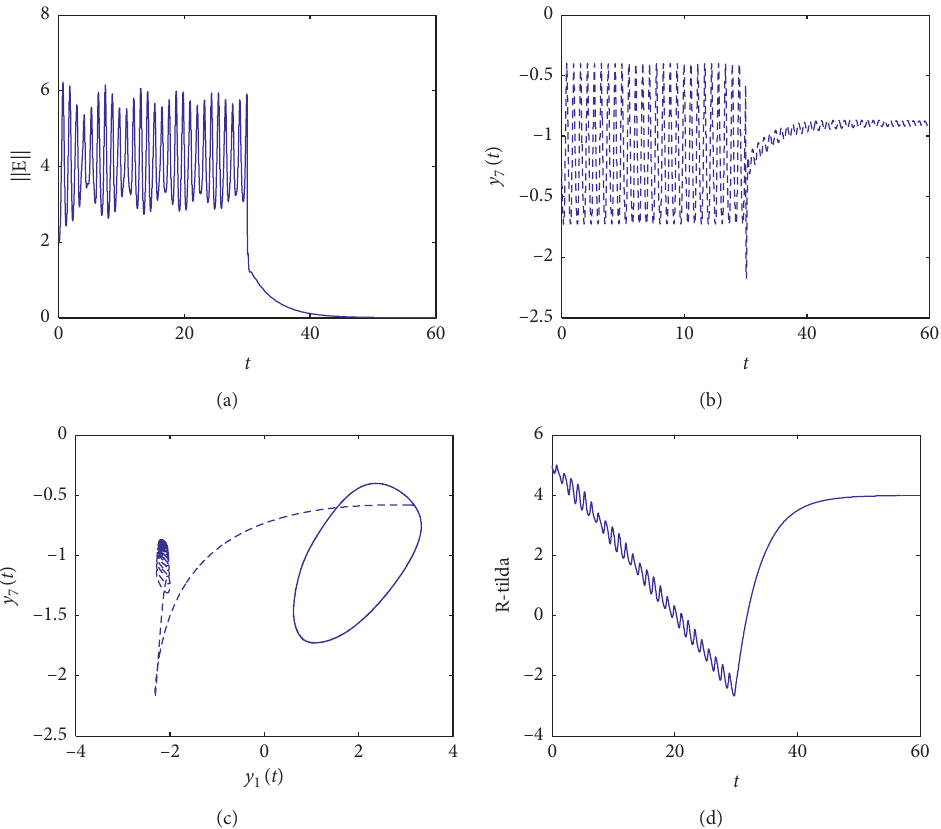
Figure 5: Adaptive control of the periodic regime of the slave system at R �������� 􏽱 | y | 2 􏽐 7 t � 30. (a) The L -norm ‖ E ‖ � vs. time. (b) The state y i i � 1 2 ( t ) vs. y ( t ) . (d) Time evolution of 􏽢 R , the estimate of R � R slave system y 7 1